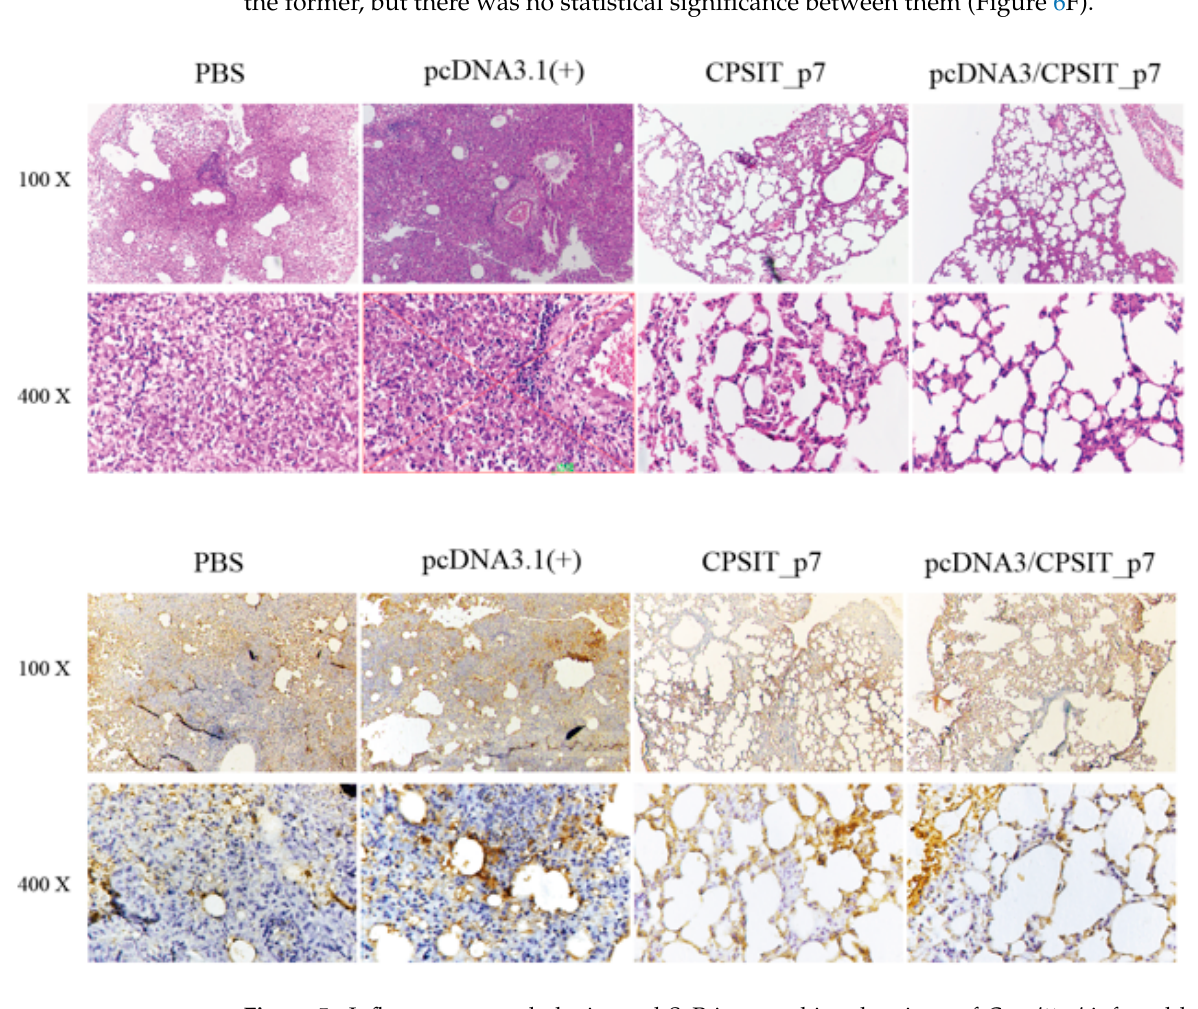
Figure 5. Inflammatory pathologies and S–P immunohistochemistry of C. psittaci -infected lung tis- sue. ( A ) Representative results of hematoxylin–eosin (H&E) staining in the lungs of control and